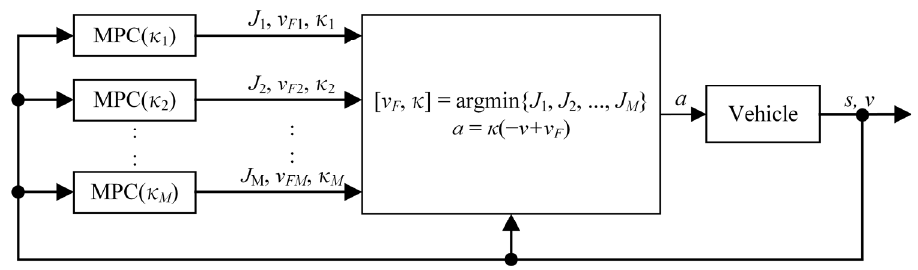
Figure 5. Block diagram of parallel MPC.